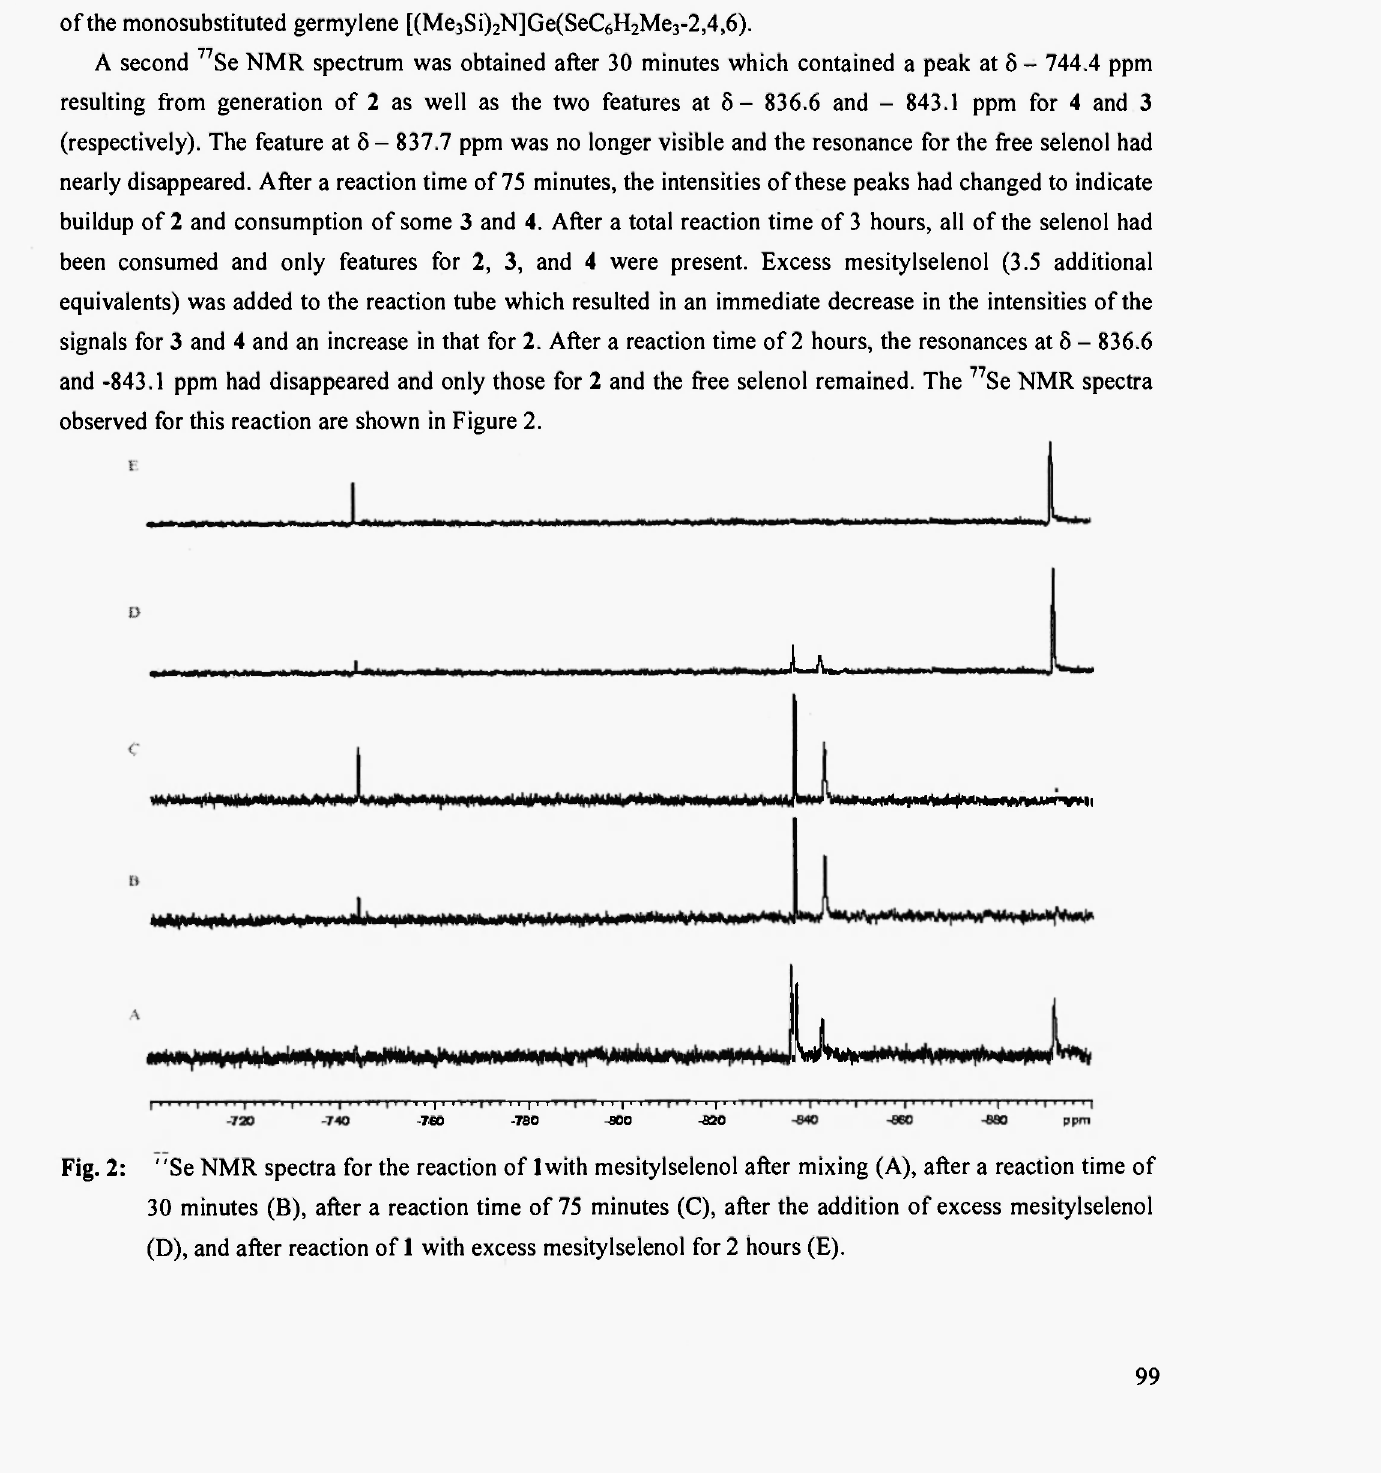
Fig. 2: Se NMR spectra for the reaction of lwith mesitylselenol after mixing (A), after a reaction time of 30 minutes (B), after a reaction time of 75 minutes (C), after the addition of excess mesitylselenol (D), and after reaction of 1 with excess mesitylselenol for 2 hours (E).